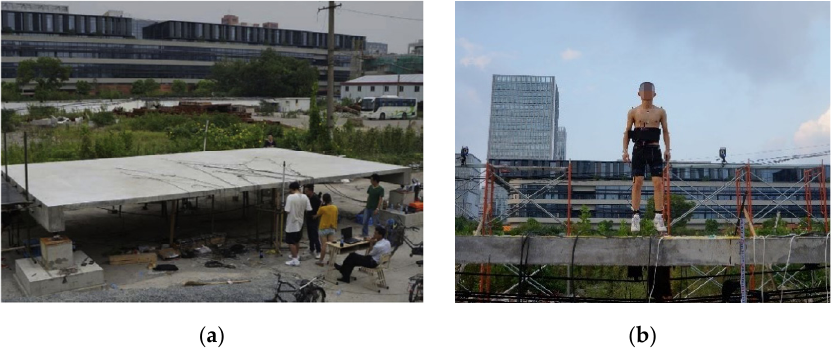
Figure 7. Experimental setup: ( a ) Overview of the large-span plate; ( b ) Test participant on the structure.